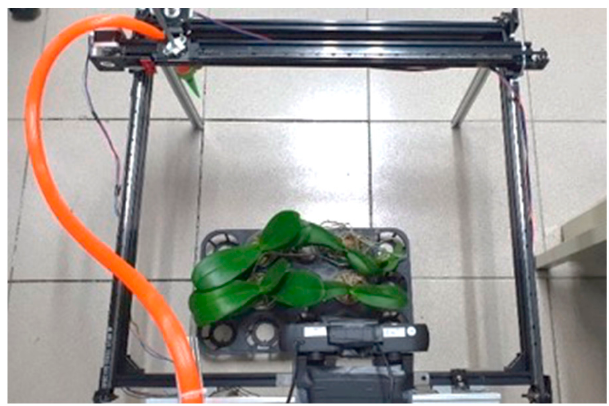
Figure 34. The configuration of the multiple-seedling experiments.